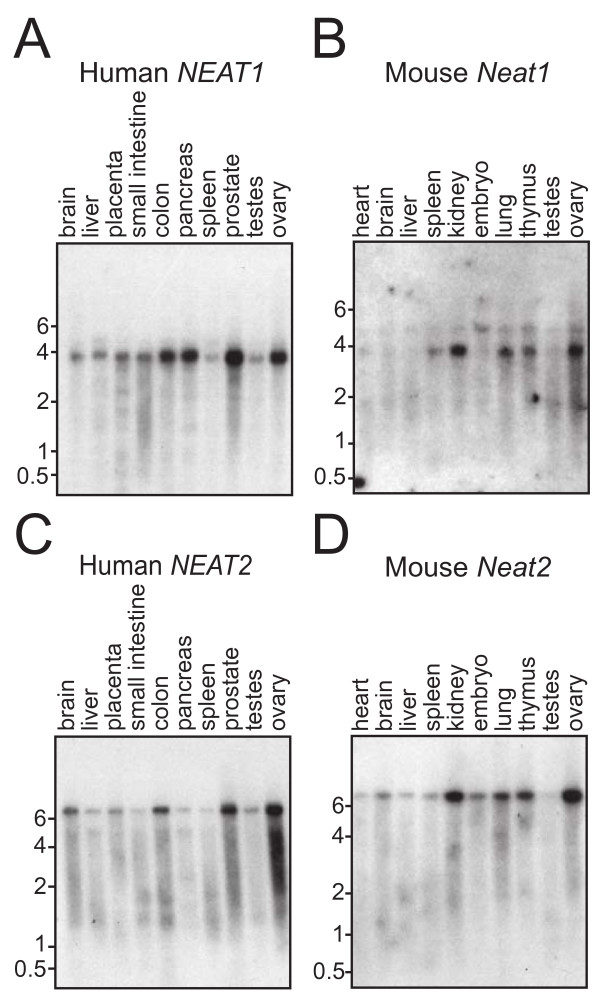
Northern Analysis of NEAT1 and NEAT2/MALAT-1 in mouse and human tissues. Radiolabeled probes to NEAT1 and NEAT2/MALAT-1 show a ~3.5 kb transcript for the human and mouse NEAT1 loci (A,C) and a transcript of more than 6 kb for the human and mouse NEAT2 loci (B,D). The analyses were carried out using First Choice Northern Blots (Ambion), which contain 2 micrograms each of poly(A) RNA from various tissues. Equal loading of RNA is ensured by Ambion for each lot of blots with either GAPDH or beta-actin probes for human or mouse blots respectively. Difficulties in transferring large transcripts to Northern blots may explain the absence of a larger (>17 kb), NEAT1 transcript (data not shown and [29]).